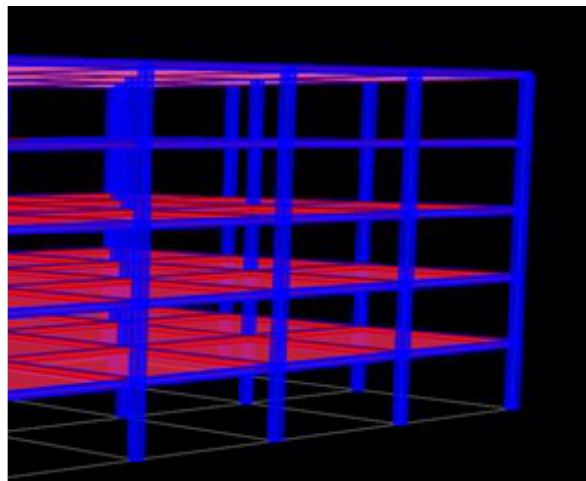
Figure 9. Layout without deformation